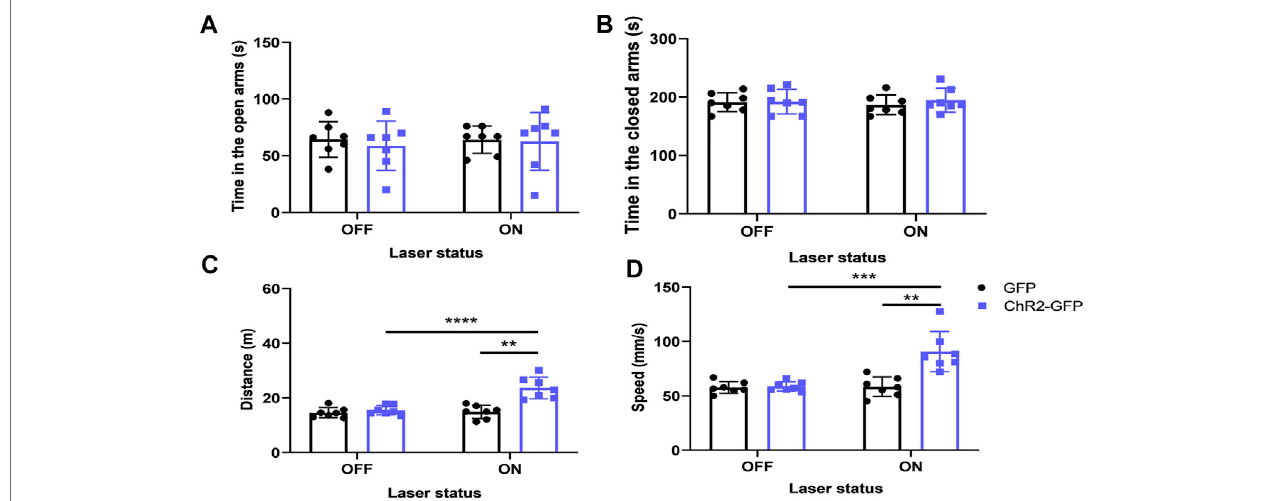
FIGURE8| OptogeneticactivationofthePVN-PVTneuralcircuitdoesnotaffectanxiety-likebehaviorsinmice. (A) OpticalstimulationofPVNprojectionstothePVT did not affect the open-arms time in the EPM test. (B) Optical stimulation of PVN projections to the PVT did not affect the close-arms time in the EPM test. (C) Optical stimulation of PVN projections to the PVT increased the moving distance of the mice. (D) Optical stimulation of PVN projections to the PVT increased the speed of the mice (* p < .05, ** p < .01, *** p < .001, n = 7/group. Error bars denote SEM. Two-way ANOVA test).